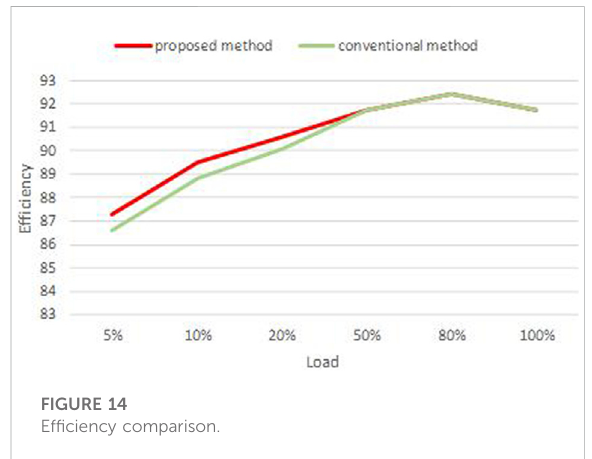
FIGURE 14 Ef fi ciency